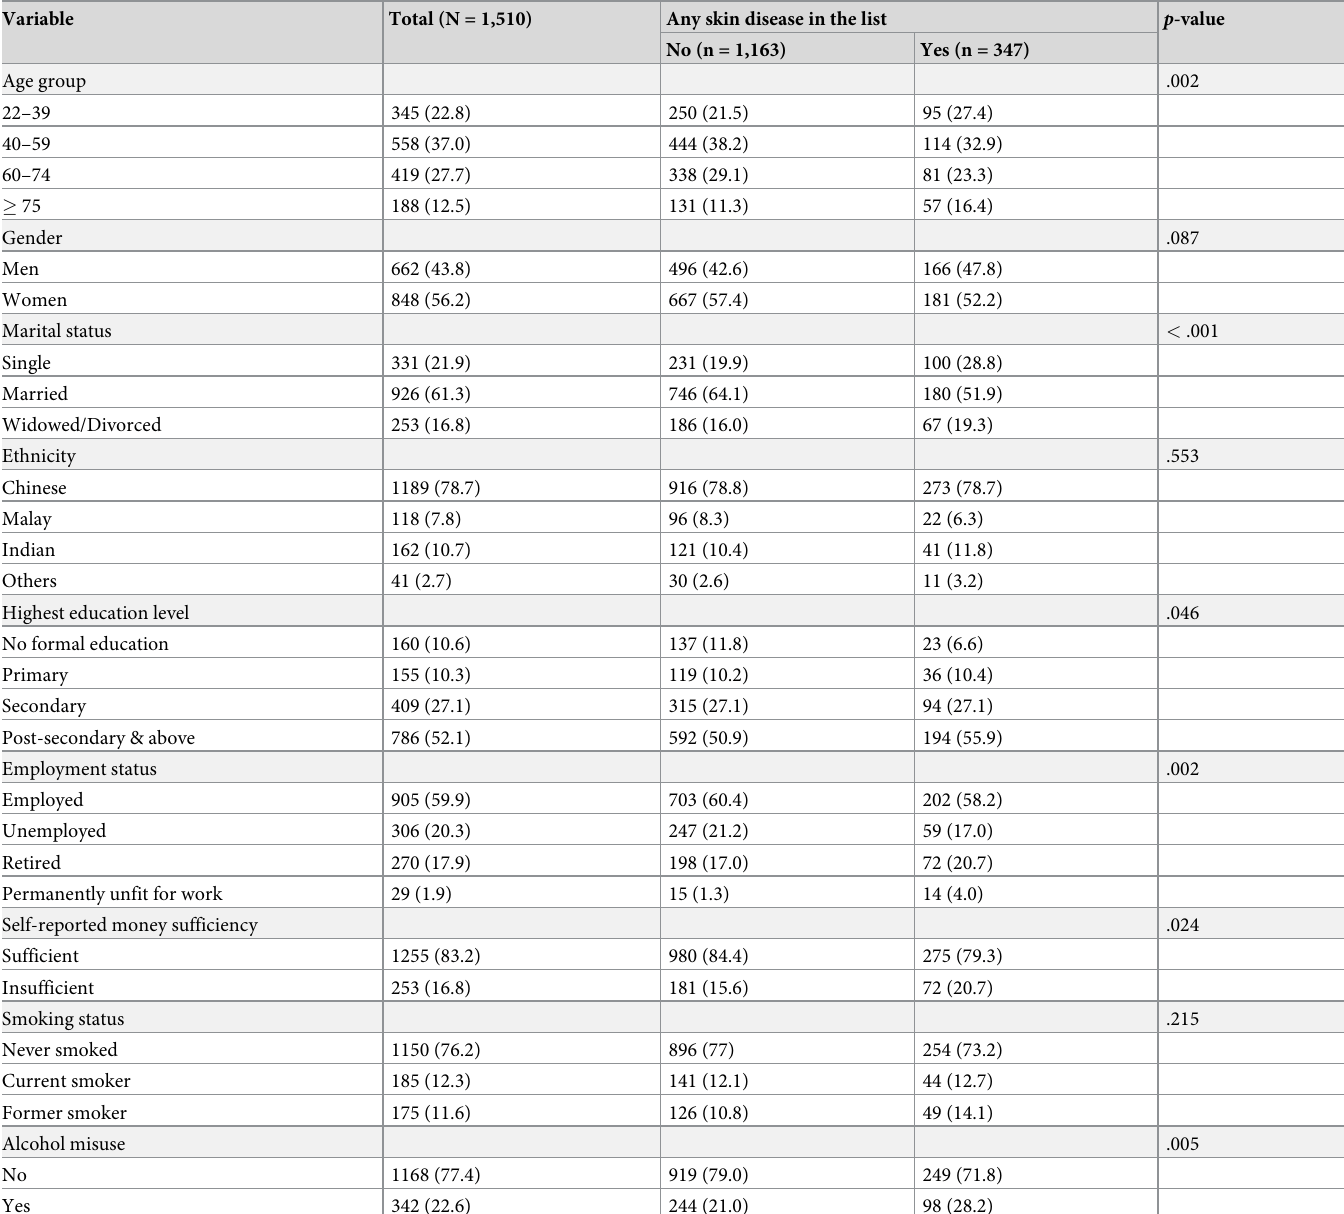
Table 1. Demographics by history of any listed skin diseases, n